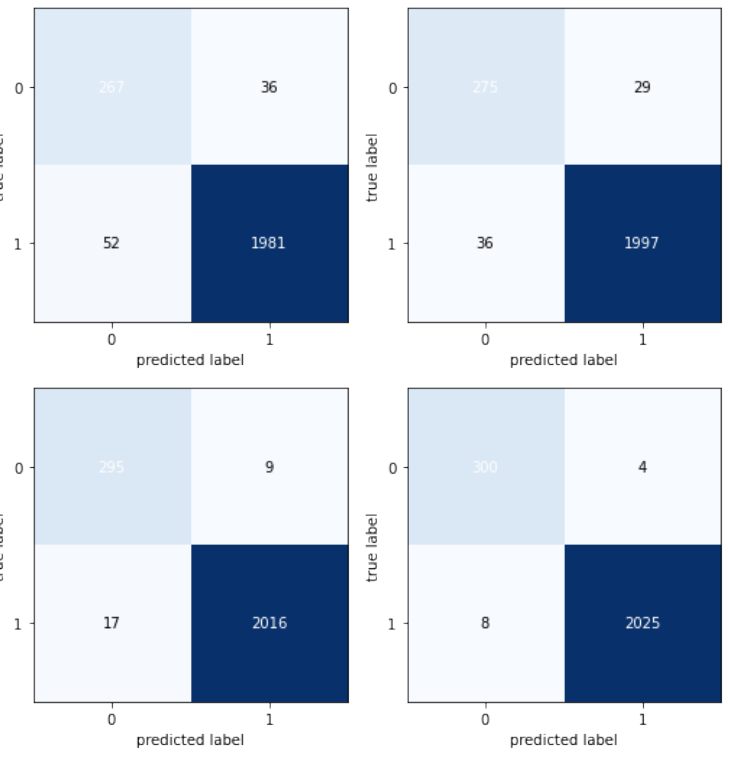
Figure 4. Confusion matrix for the different methods: LSTM [23], CNN-LSTM [16], transformer encoder (our method), and LSTM encoder (our method), from left to